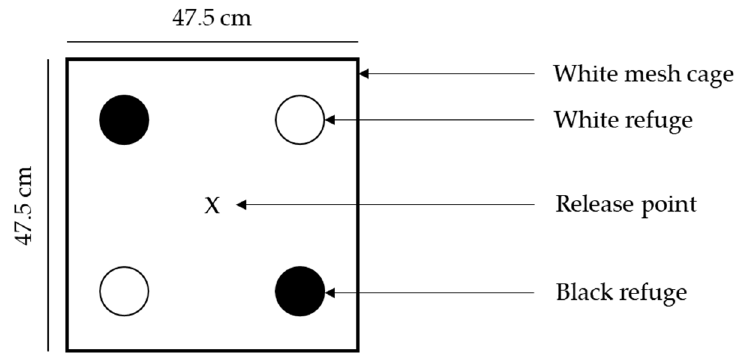
Figure 1. Schematic diagram showing the arrangement within each mesh cage for the refuge colour (dark vs. light) experiment. Refuge positions are shown in circles and the vine weevil release point using an x mark.